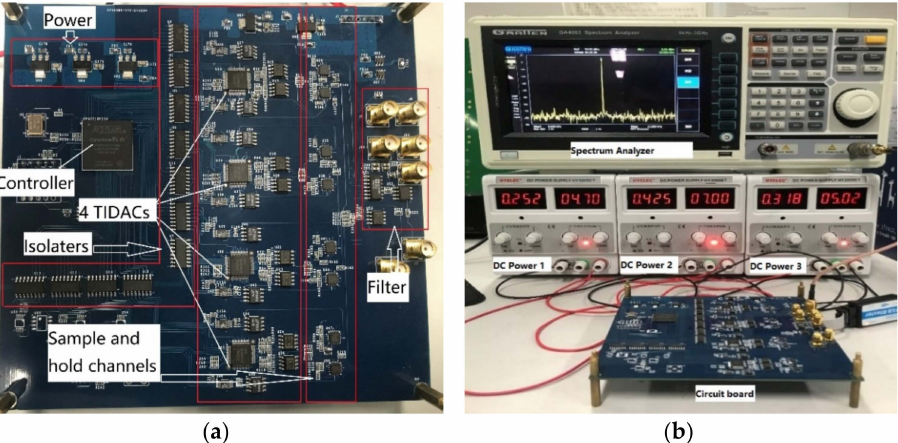
Figure 12. ( a ) The specifically designed circuit board and ( b ) the actual test connection